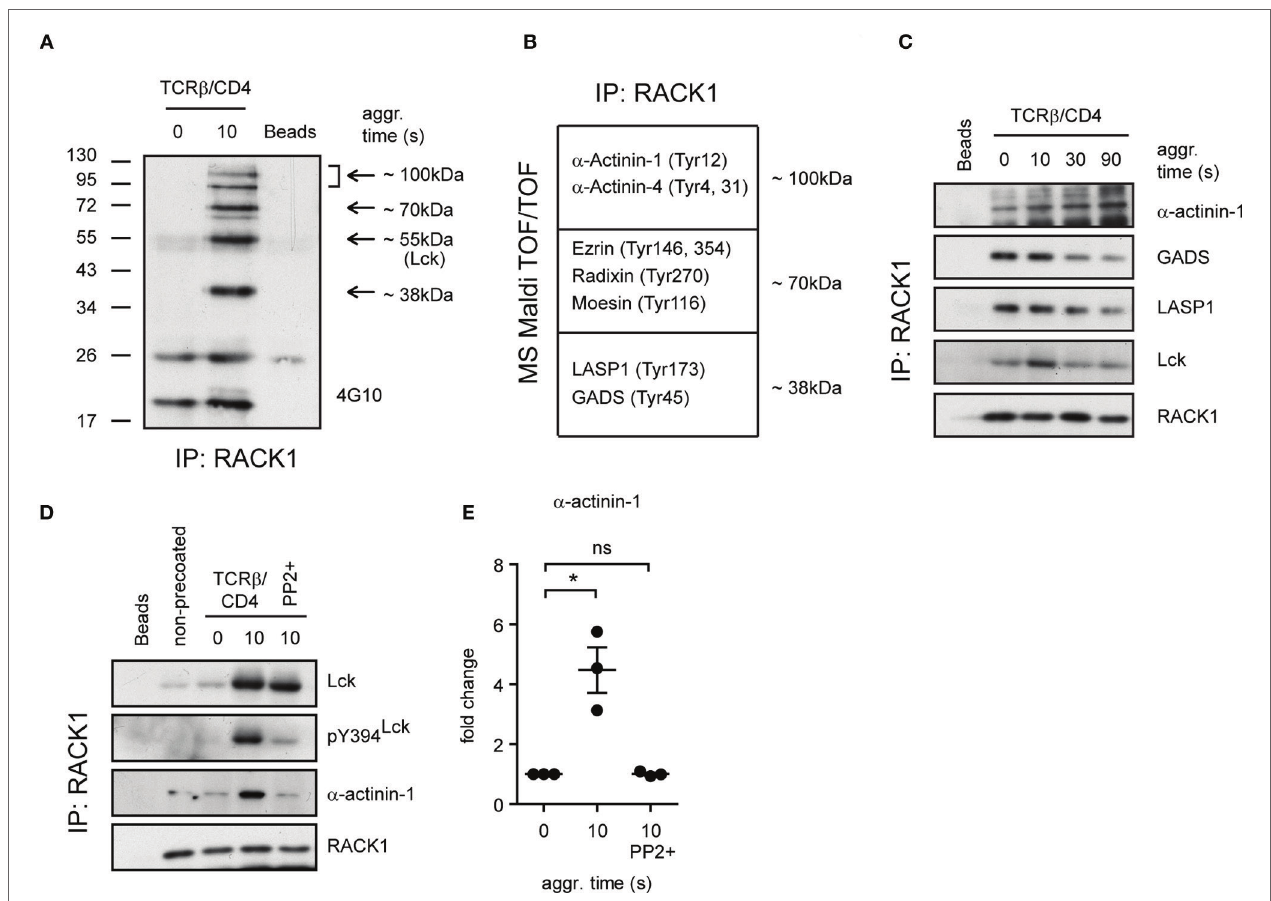
FigUre 6 | identification of additional components of racK1–lck complexes . (a) RACK1 immunoprecipitates from non-activated (0 s) and activated (10 s) CD4 + T-cell samples, and beads alone, were probed with anti-pY antibody (4G10). The arrows point to areas that show readily detectable phosphoproteins co-immunoprecipitating with RACK1. In the coomassie blue-stained gel, the areas depicted by arrows from all three samples were extracted (except for the 55-kDa area) and subjected to MALDI TOF/TOF MS analysis. A selected list of size-related and identified proteins with their potential pY sites are shown in (B) . The bead sample was negative for these proteins. (c) The kinetics of complex formation between RACK1 and indicated proteins before (0) and at the indicated time points after TCR β /CD4 co-aggregation. RACK1 immunoprecipitates were probed with anti- α -actinin-1, anti-GADS, anti-LASP, anti-Lck, and anti-RACK1. (D) CD4 + T-cells were treated (PP2 + ) or not with PP2 inhibitor, activated, and lysed in TNE lysis buffer. RACK1 was immunoprecipitated, and samples were blotted against Lck, pY394 Lck , α -actinin-1, and RACK1. (e) Statistical analysis of (D) , actinin-1 panel, represents the relative fold change of RACK1 co-immunoprecipitated actinin-1 normalized to total RACK1. The statistical analysis presented as mean ± SD was performed using the Student’s two-tailed t -test, * p < 0.05, n.s., not significant. Blots shown in (c,D) are representative of three independent